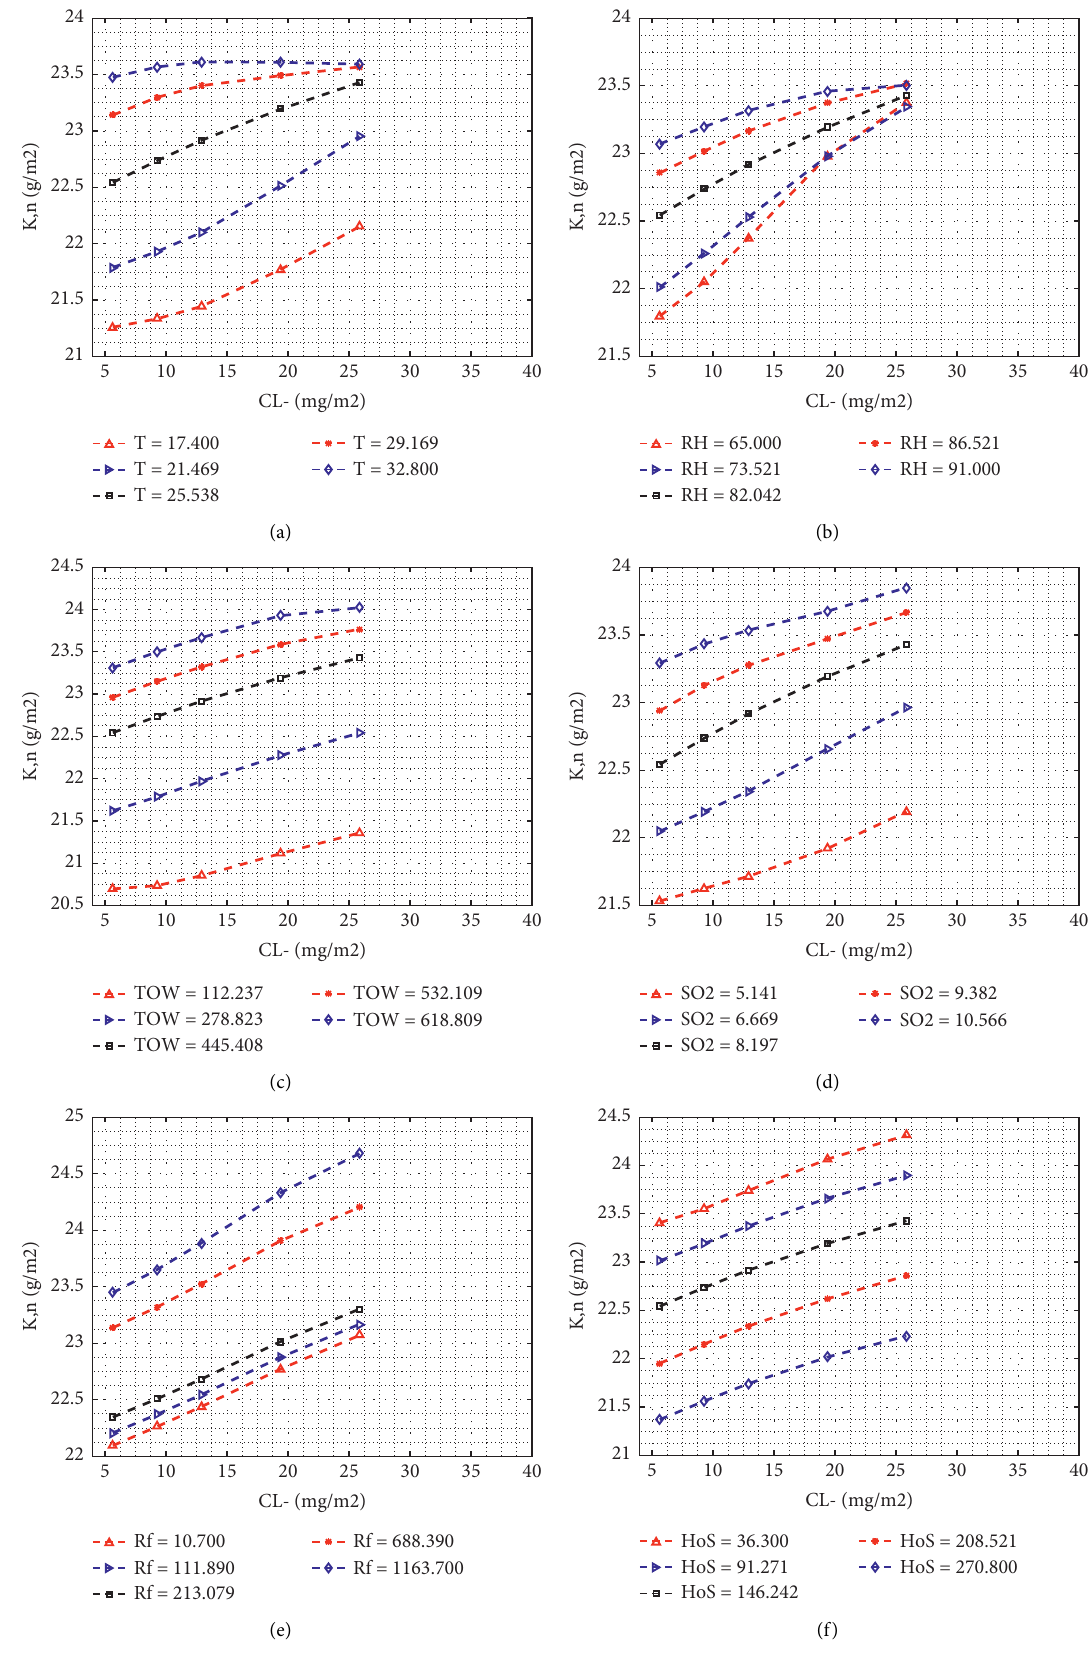
Figure 16: Effect of the average chloride deposition